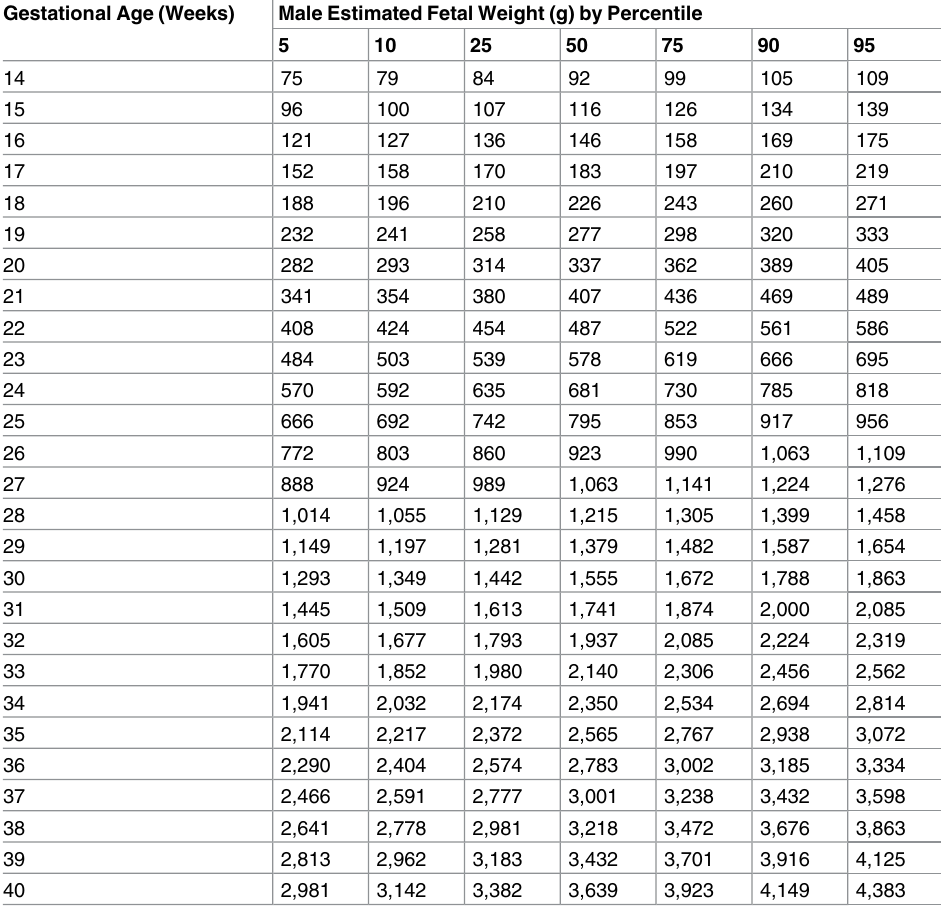
Table 15. Growth chart for estimated fetal weight (EFW) for male